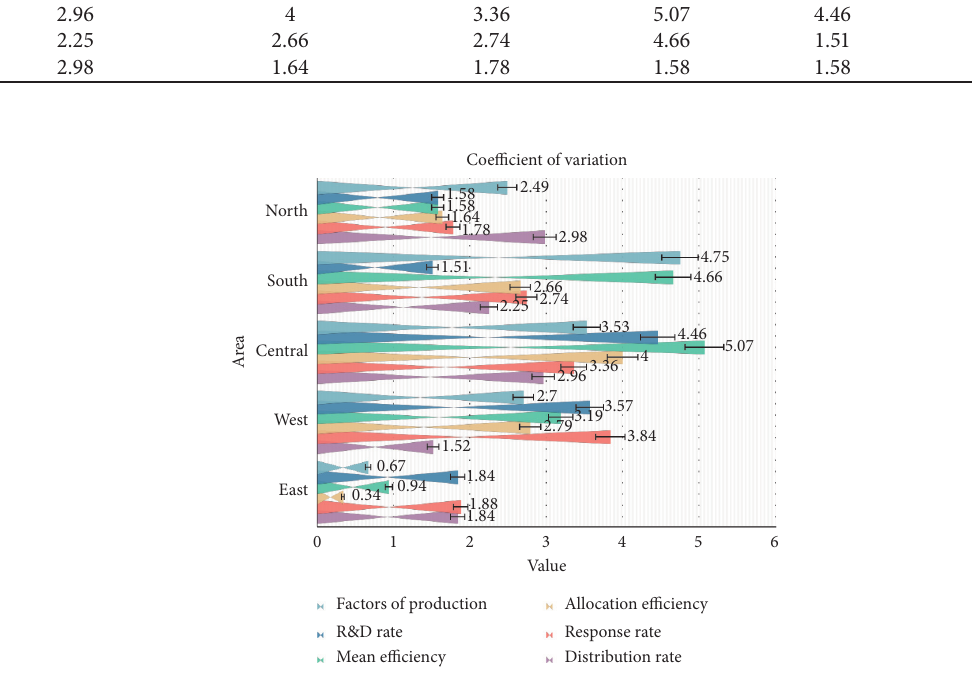
Figure 12: Coefficient of variation of the average rate of return on national R&D resources.